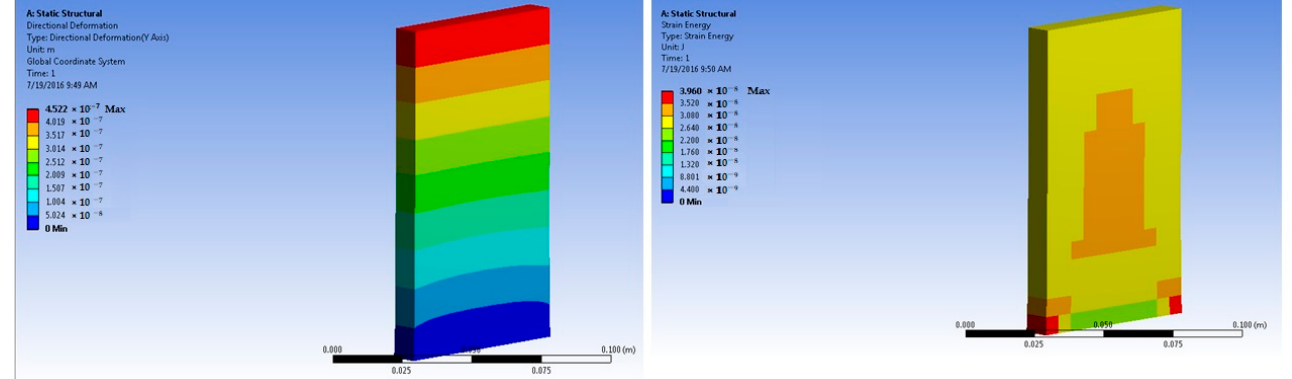
Figure 21. Three percent coarse-aggregate-based concrete slab at 50 × 10 5 N force (deformation and strain